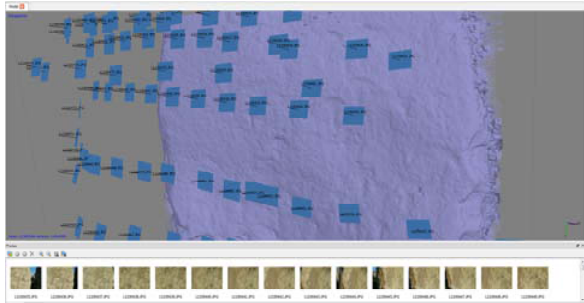
Figure 9 Example SfM processing for Stonehenge (image courtesy of Marcus Abbott,